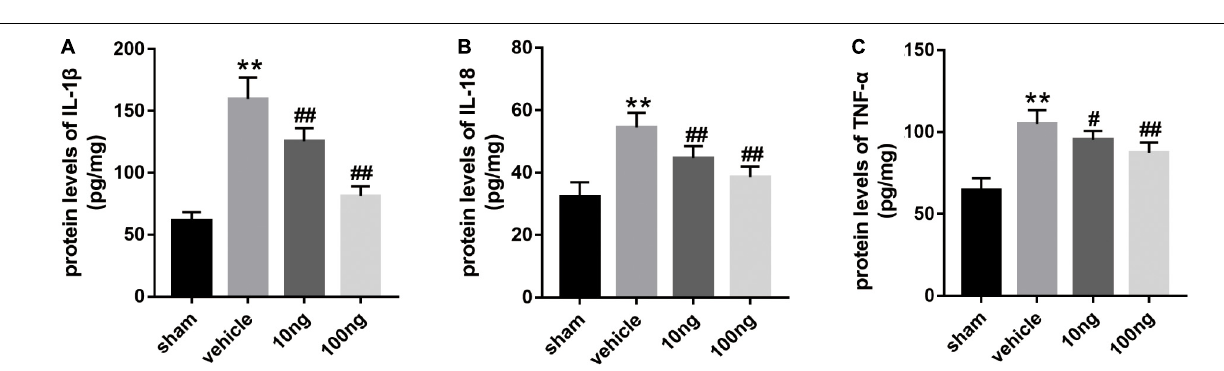
MaR1 Suppressed